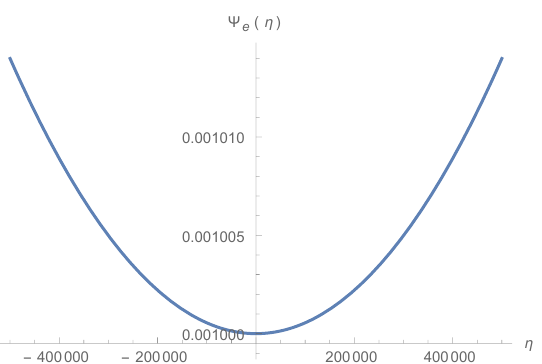
Figure 11. Time evolution of Ψ e in the Jordan frame for the initial conditions Φ e ( 0 ) = − 10 − 2 , − 3 , Φ (cid:48) Ψ ( 0 ) = 0, Ψ (cid:48) ( 0 ) = 0. The background evolution is the one obtained by assuming the e ( 0 ) = 10 e e same initial conditions as mentioned in the caption of Figure 2.